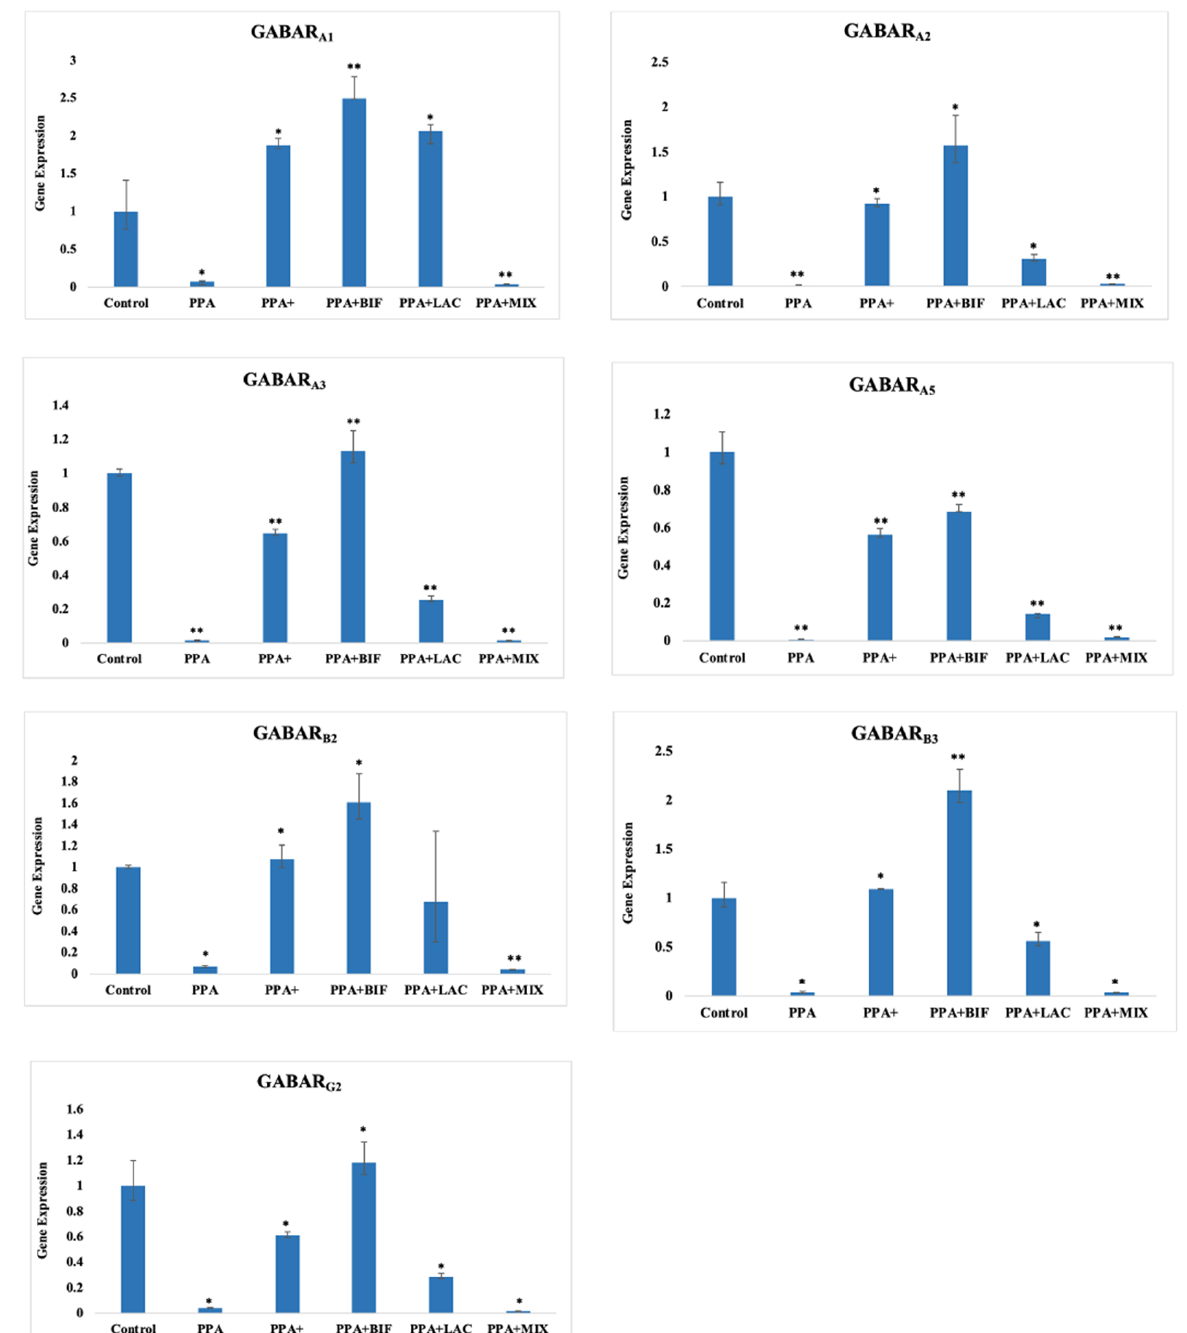
Figure 3. Effect of probiotic treatments on the gene expression of GABAR A , GABAR B , and GABAR G selected subunits in the brain homogenates of male western albino young rats in all groups. (*) The mean difference is significant at p ˂ 0.001, and (**) the mean difference is significant at p ˂ 0.0001 .